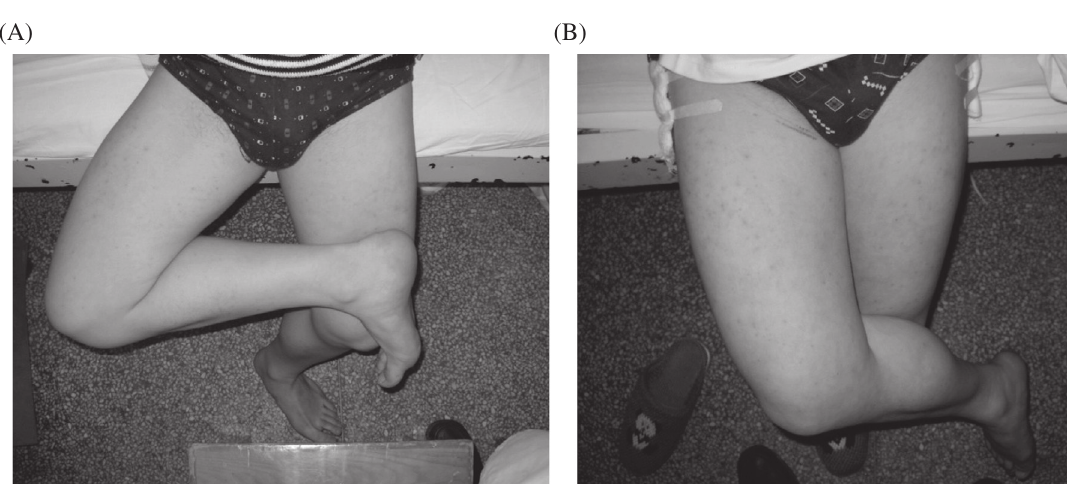
Figure 5. Pre-operative vs. post-operative photograph of a patient with bilateral GMC who underwent endoscopic release using the two- portal technique. (A) The patient demonstrated an abducted and external rotation contracture of the right hip preoperatively where the patient was unable to cross his leg; whereas (B) immediate post-operative photograph: the patient was able to cross the